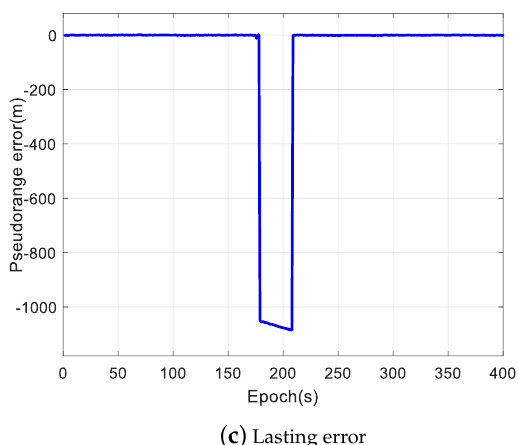
Figure 3. Pseudorange errors observed by the LING QIAO GNSS receiver in